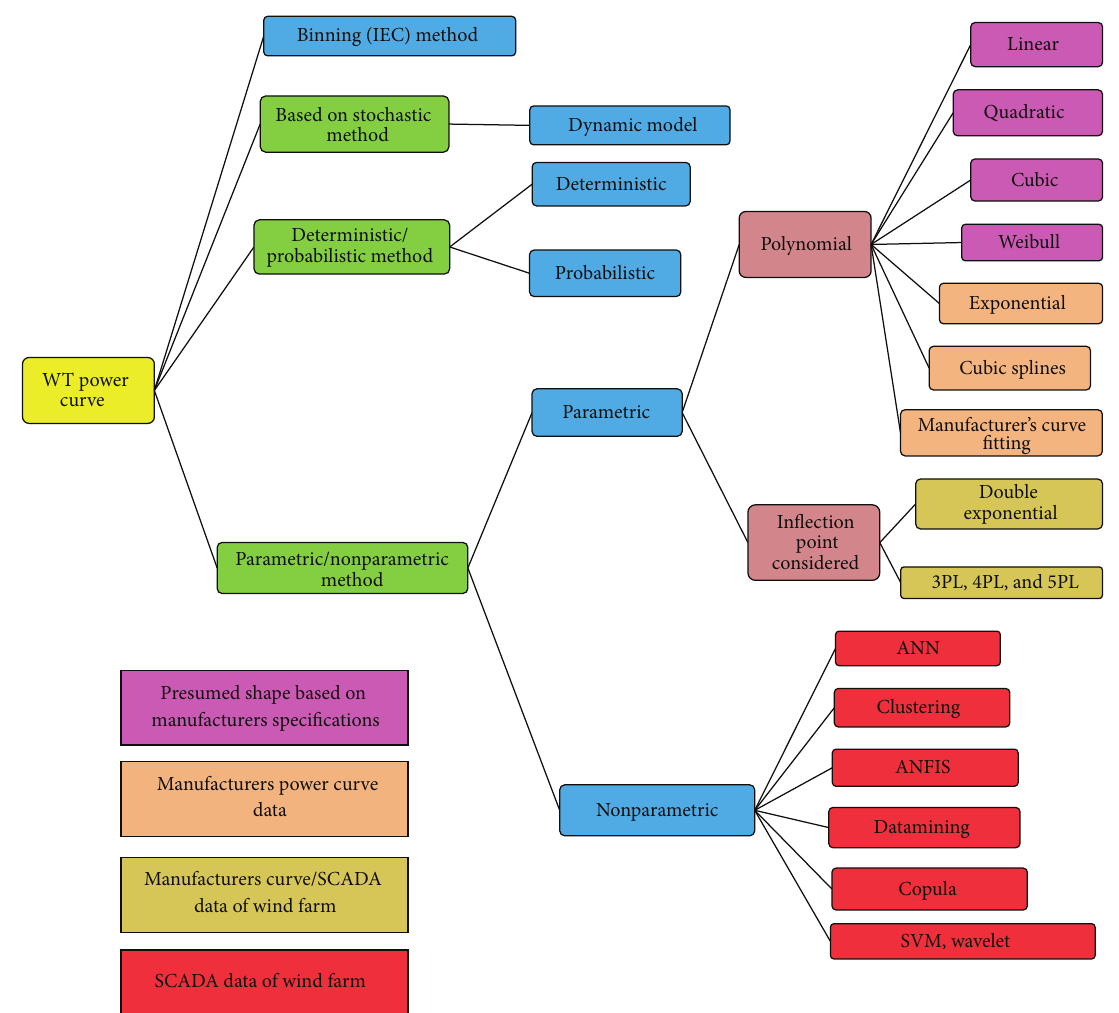
Figure 3: Wind turbine power curve